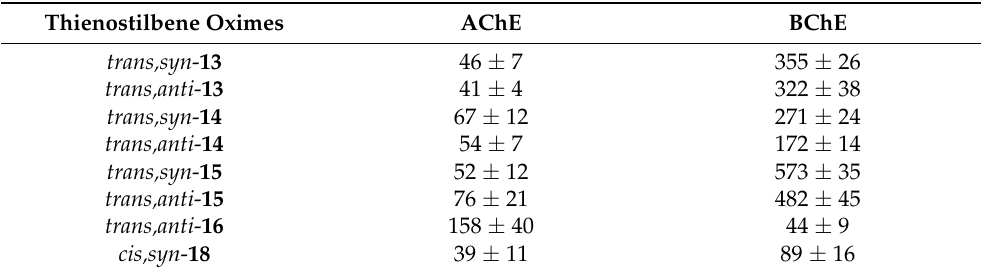
Table 2. Dissociation constants, K i ( µ M) ± SE, for reversible inhibition of human acetylcholinesterase (AChE) and butyrylcholinesterase (BChE) with new oximes at 25 ◦ C. Thienostilbene Oximes AChE BChE trans,syn - 13 46 ± 7 355 ± 26 trans,anti - 13 41 ± 4 322 ± 38 trans,syn - 14 67 ± 12 271 ± 24 trans,anti - 14 54 ± 7 172 ± 14 trans,syn - 15 52 ± 12 573 ± 35 trans,anti - 15 76 ± 21 482 ± 45 trans,anti - 16 158 ± 40 44 ± 9 cis,syn - 18 39 ± 11 89 ±